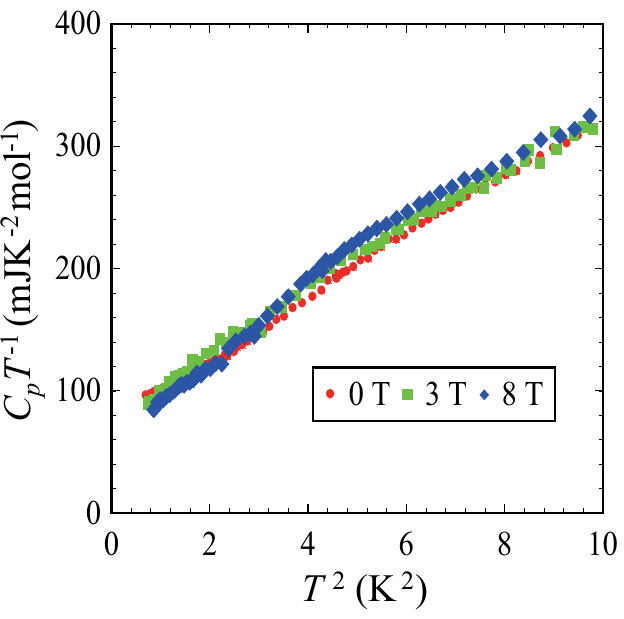
Figure 5. Temperature and magnetic field dependences of the heat capacity of (Me-3,5-DIP)[Ni(dmit) 2 ] 2 . Temperature dependences of the heat capacity of (Me-3,5-DIP)[Ni(dmit) 2 ] 2 obtained at 0, 3, 8 T shown in C p T −1 versus T 2 plot. Owing to the increase of doping, the compound shows typical metallic feature expressed by the electric contribution ( γT ) and the lattice contribution ( βT 3